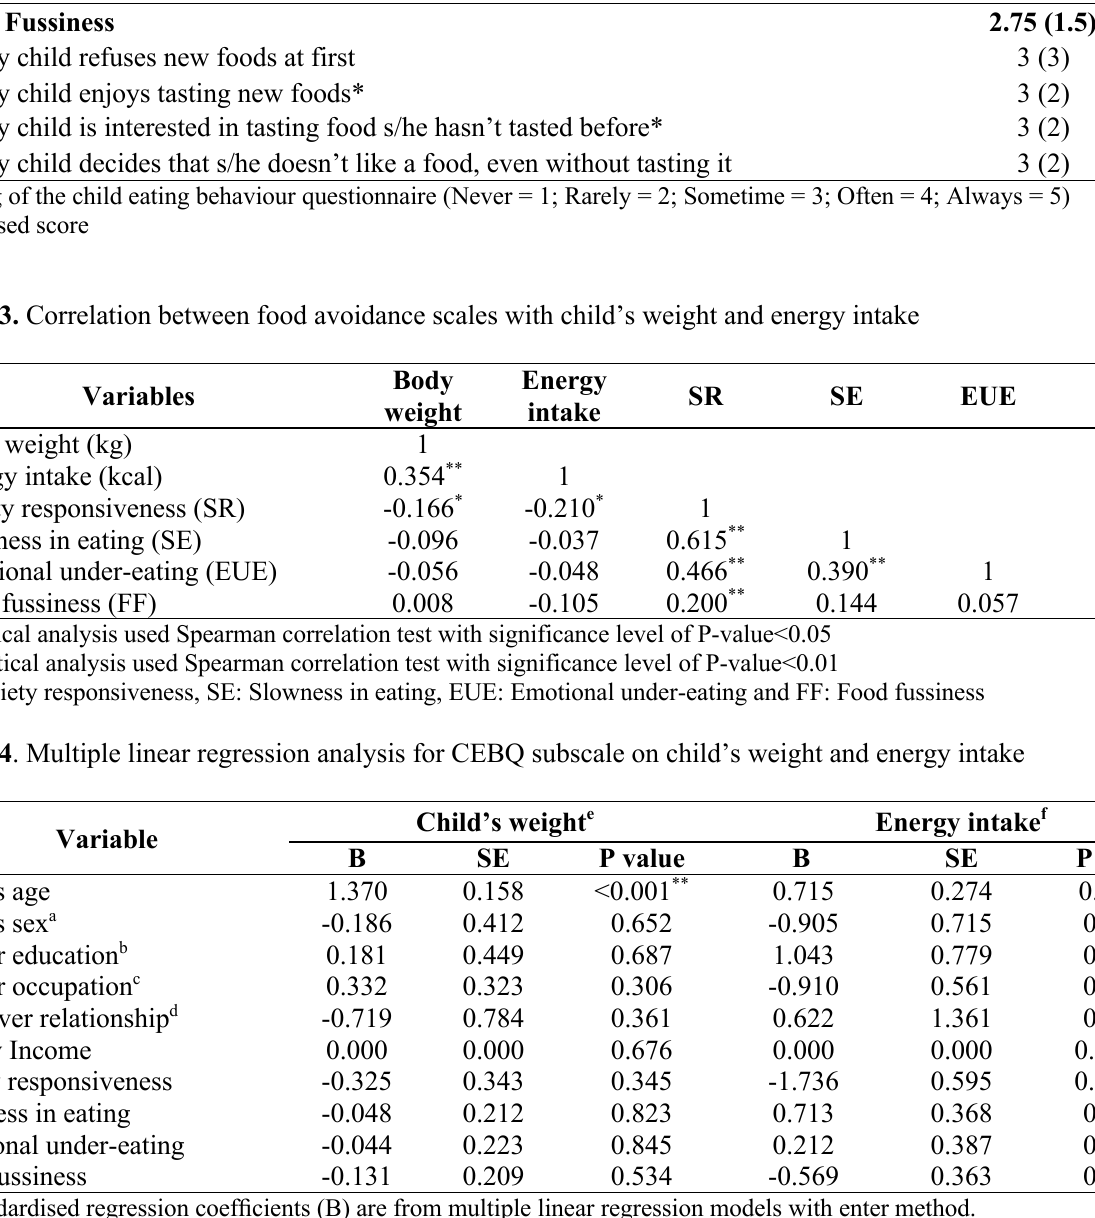
Table 2 . Distribution of food avoidance behaviour score among the subjects (continued) Food Avoidance Scale